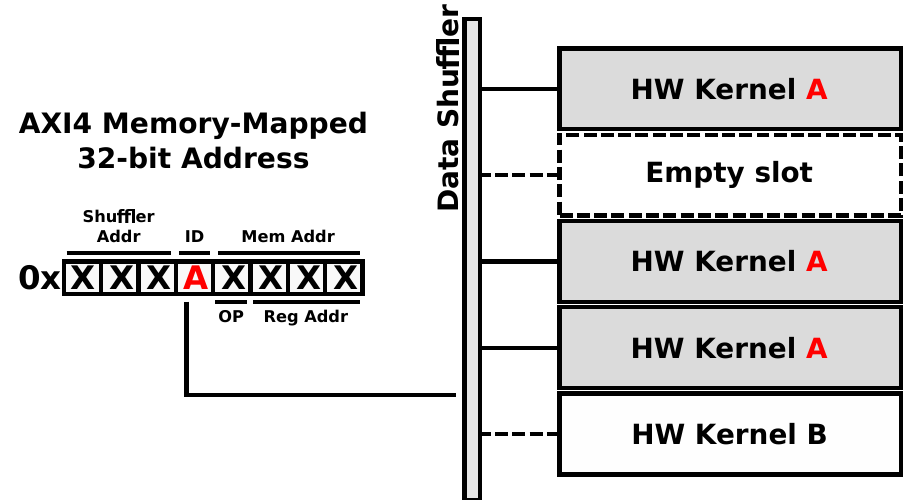
Figure 7. ARTICo 3 addressing. Accelerator locations are abstracted using an ID that is embedded within the address